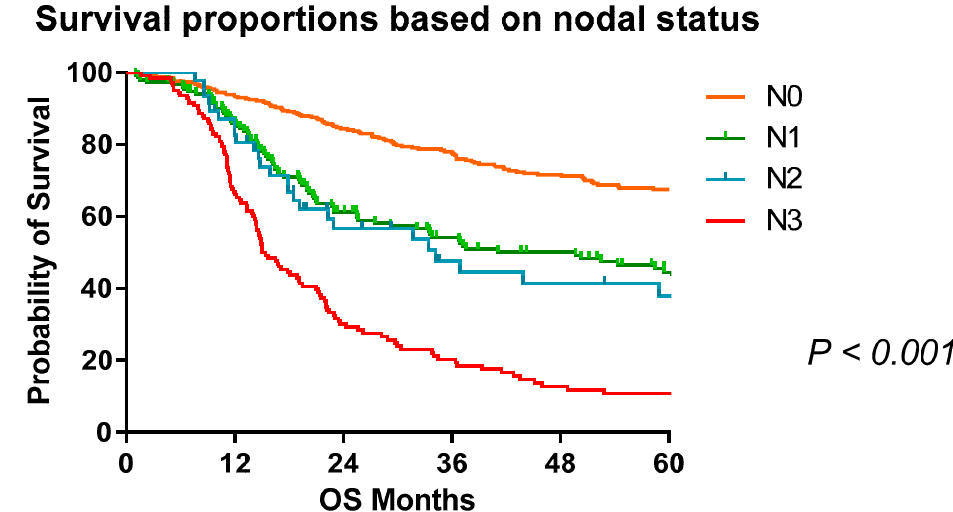
Figure 1. Survival proportions of OAC patients based on nodal status (N0 = node negative, N1 = 1–2 Nodes, N2 = 3–6 nodes, N3 ≥ 7). Any nodal disease burden significantly reduces overall survival with proportional reduction per stage of dissemination. Median survival: N0, not reached; N1, 49.7 months; N2, 34.23 months; N3, 15.43 months. Table 3. Overall number of surviving OAC patients based on nodal status (pathological post-resection).